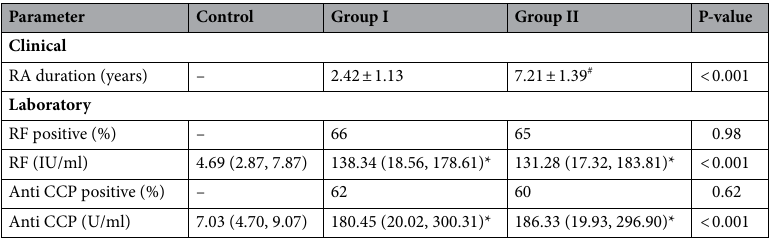
Table 2. Clinical and laboratory parameters. Data are presented as mean ± standard deviation, median (interquartile range), or positive rate. RF rheumatoid factor, Anti CCP anti-cyclic peptide containing citrulline. *Compared with control group, P < 0.05. # Compared with group I, P < 0.05.